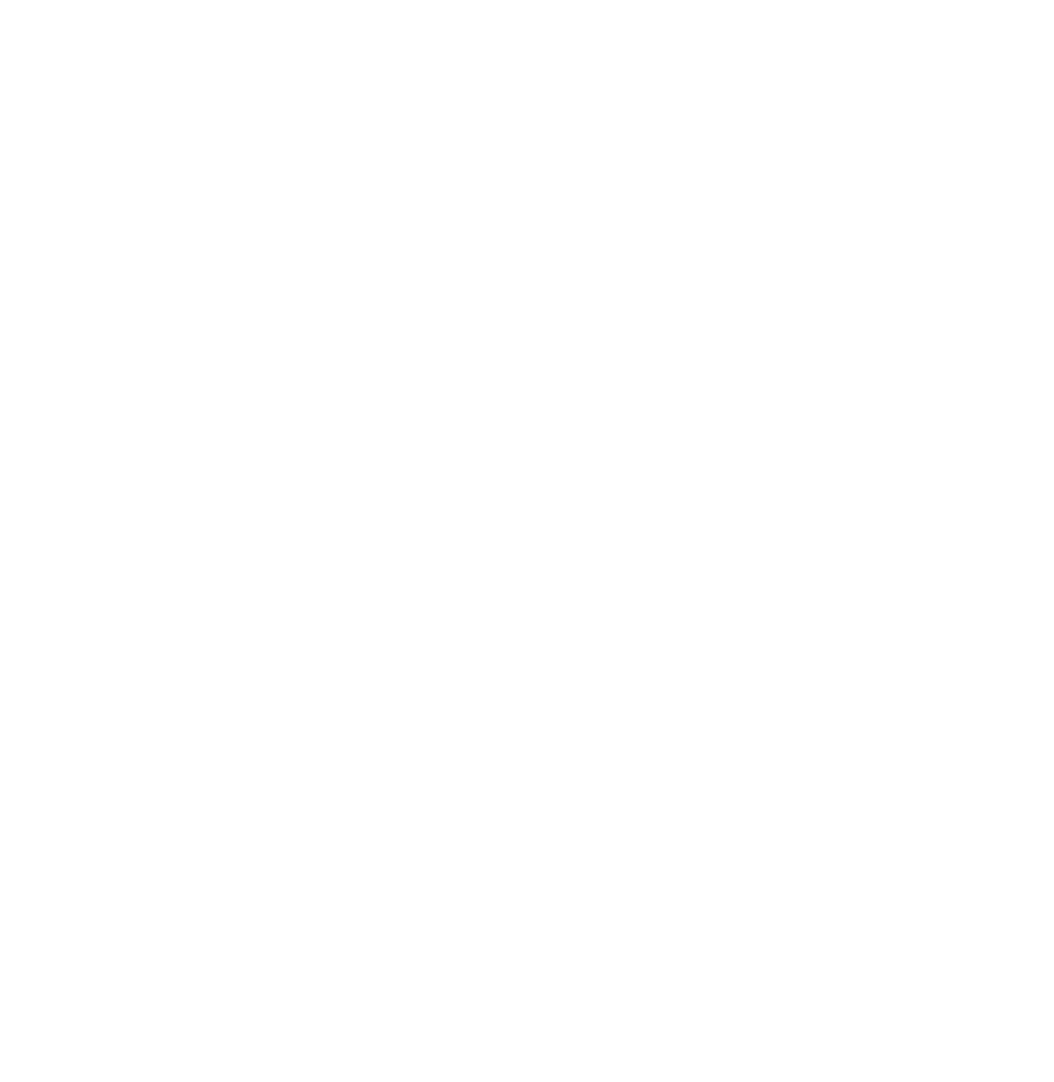
Figure 3 Face-to-face π - π